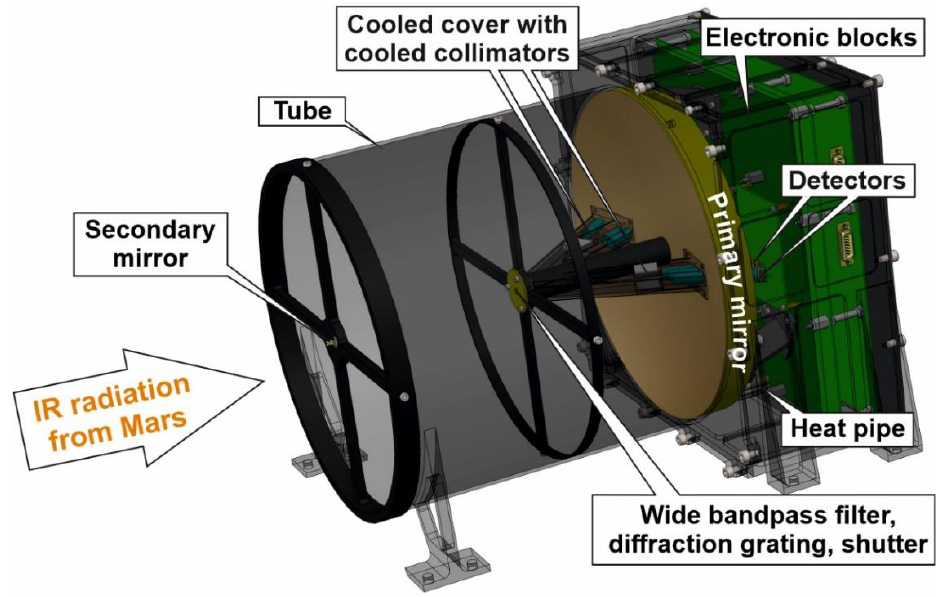
Figure 8. Simplified 3D scheme of the MIRORES instrument. The size of the instrument is 42 × 32 × 32 cm. The spectrometer has seven detectors, two of which are visible on the scheme.